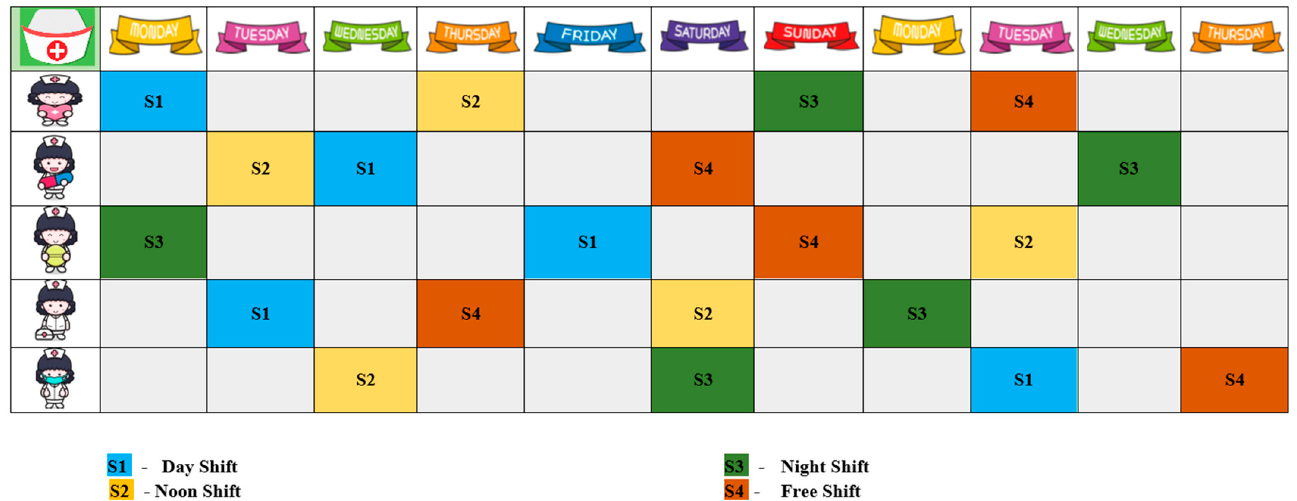
Figure 1. Visual Representation of Nurse Scheduling Problem.